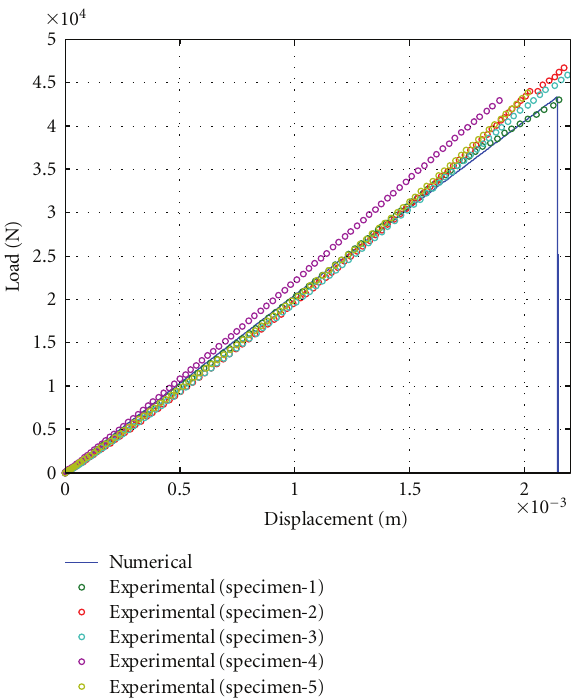
Figure 18: Comparison between numerical predictions and experimental results for the fibre tensile tests.